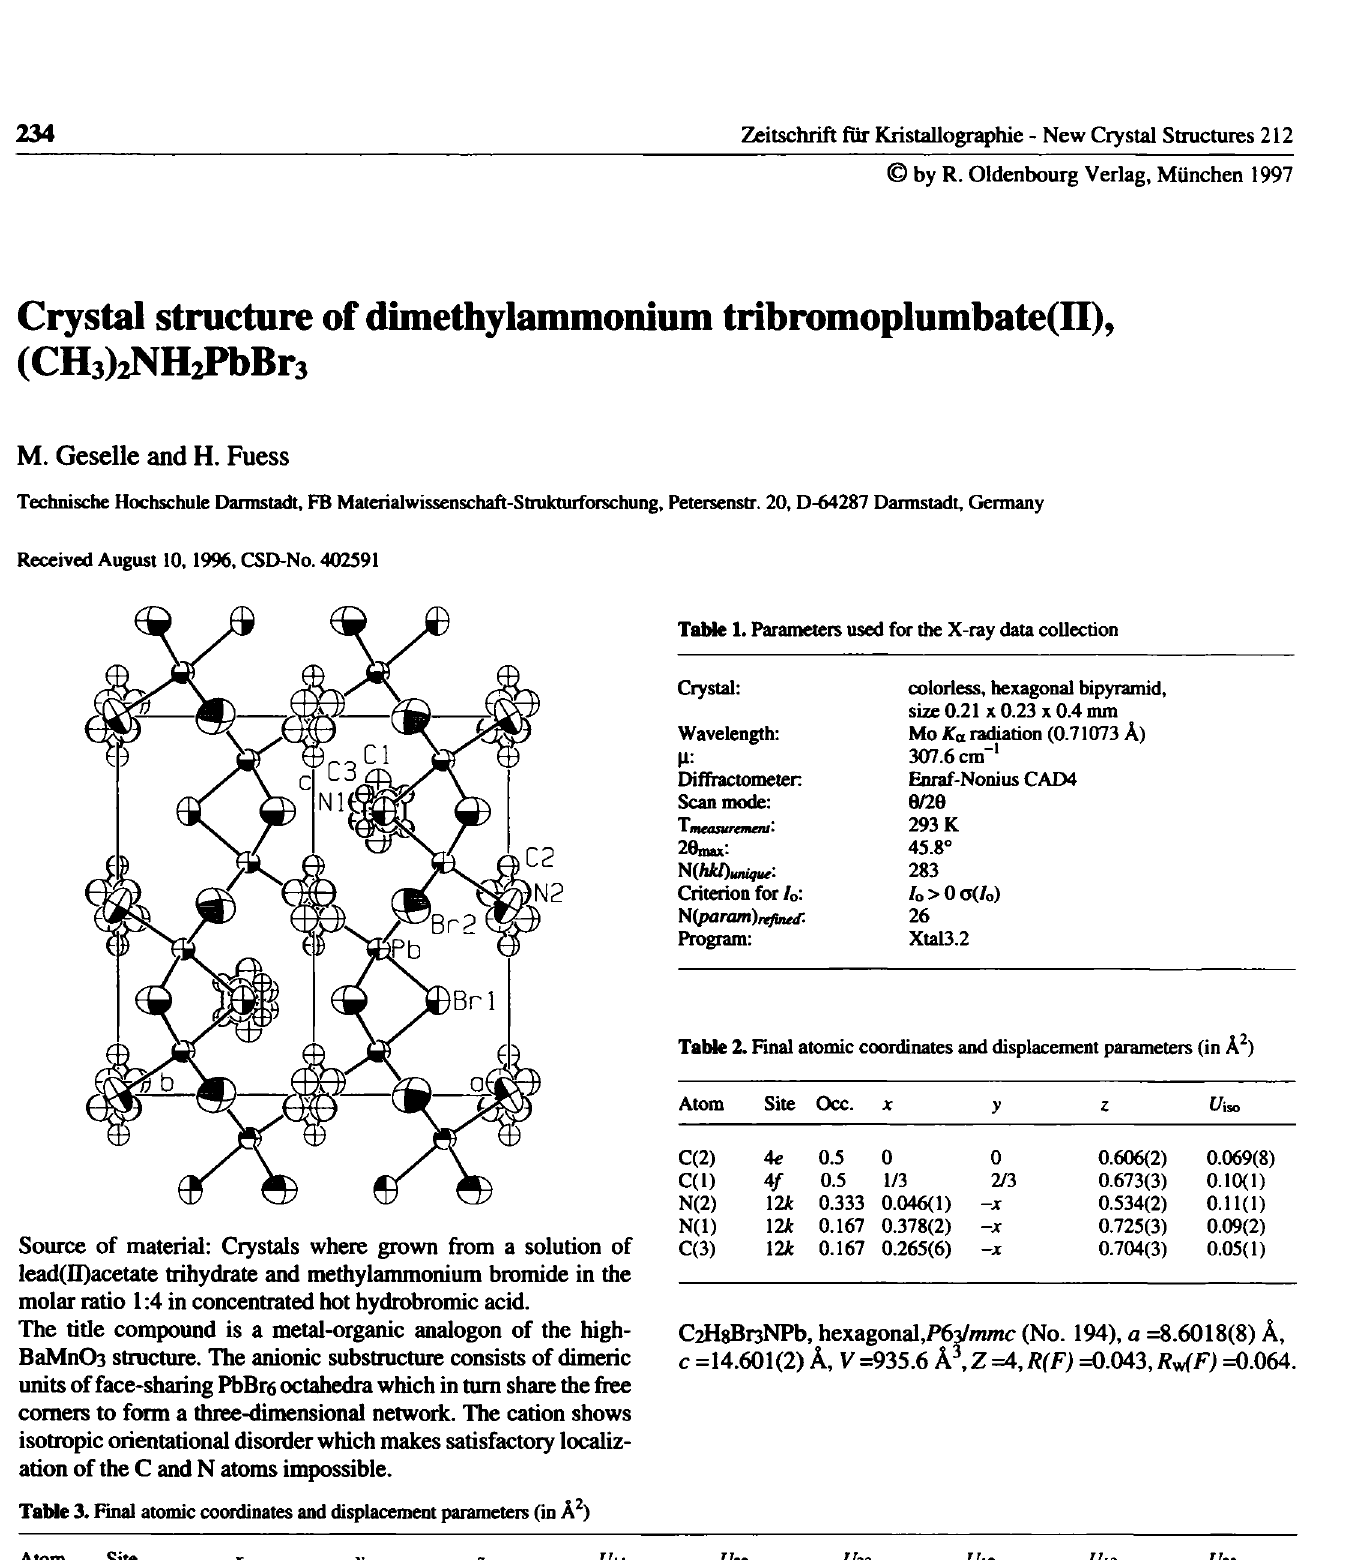
Table 3. Final atomic coordinates and displacement parameters (in Â 2 )